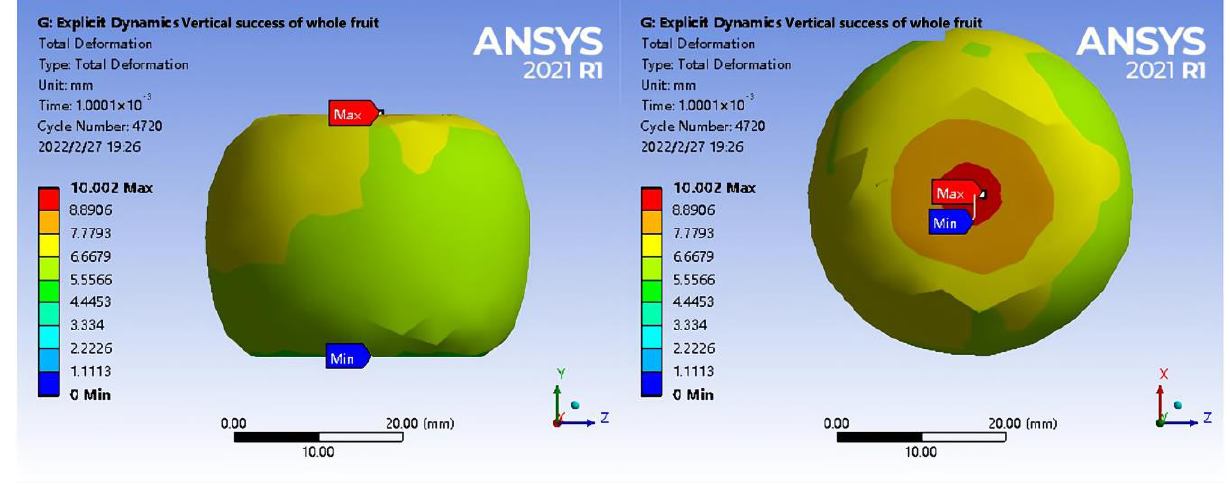
Figure 9. Total deformation diagram under axial loading.